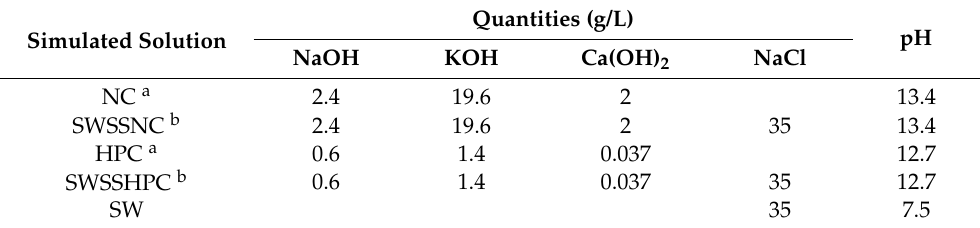
Table 2. Chemical composition and pH of test